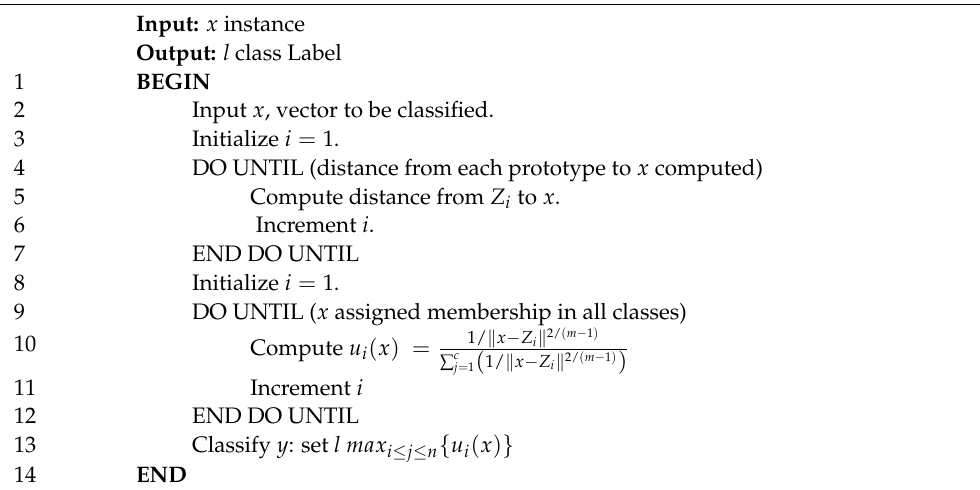
Algorithm 1. Fuzzy KNN based on distance from the prototype of the